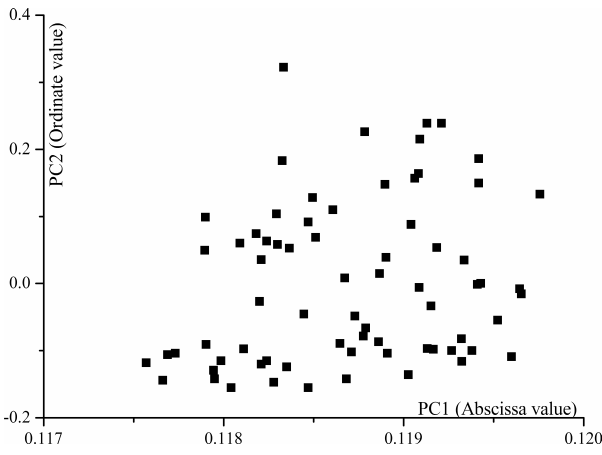
Fig. 4. PCA score plot of raw NIR spectra of Lonicerae Japonicae Flos .